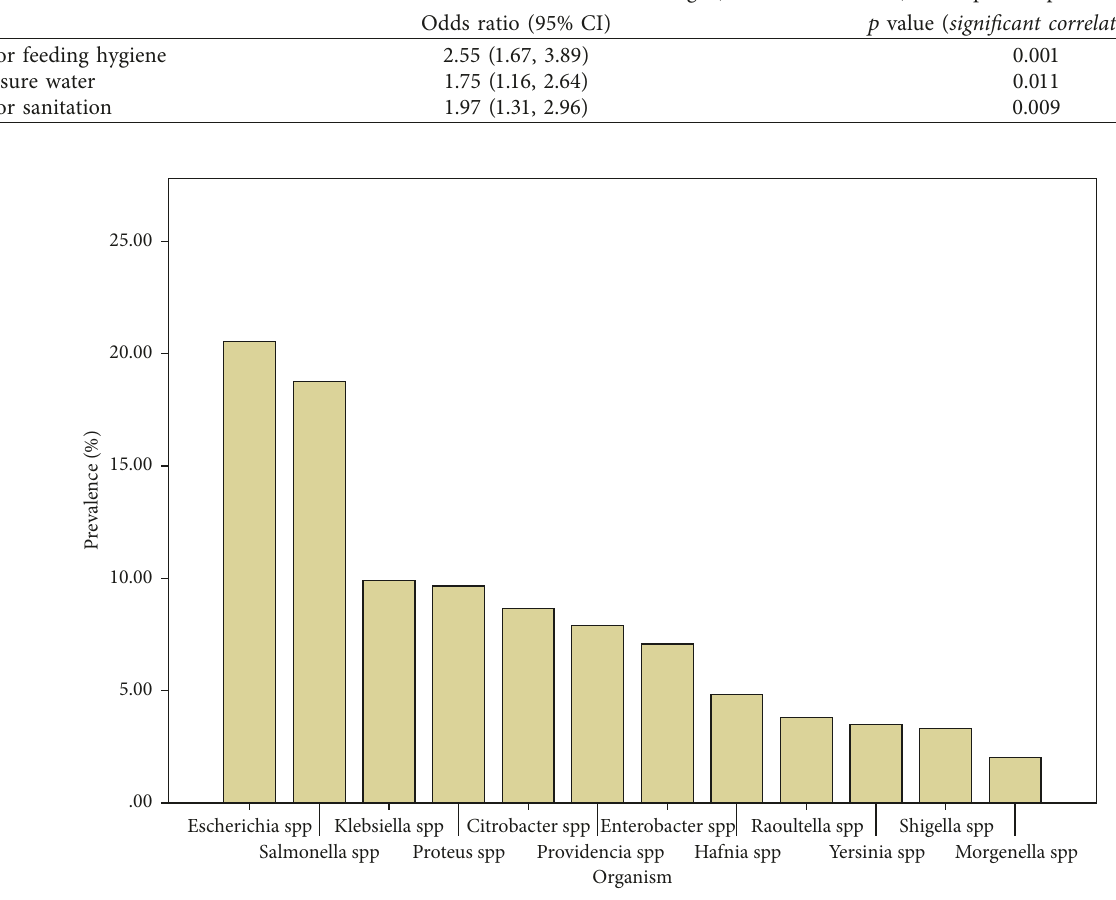
Figure 3: Prevalence of isolates of different Enterobacteriaceae